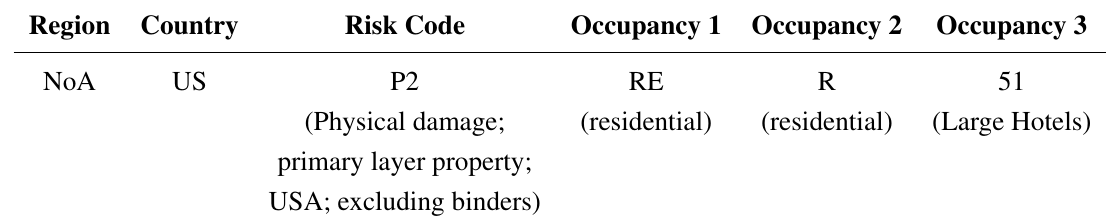
Table 1. Example of data record, with three levels of occupancy